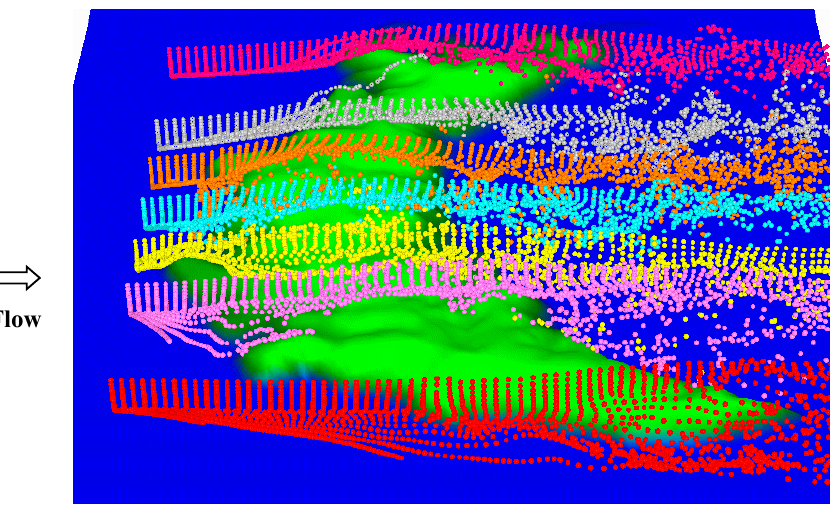
Figure 8. Examples of flows visualized with the passive particle tracking method, northerly wind, bird’s eye view.